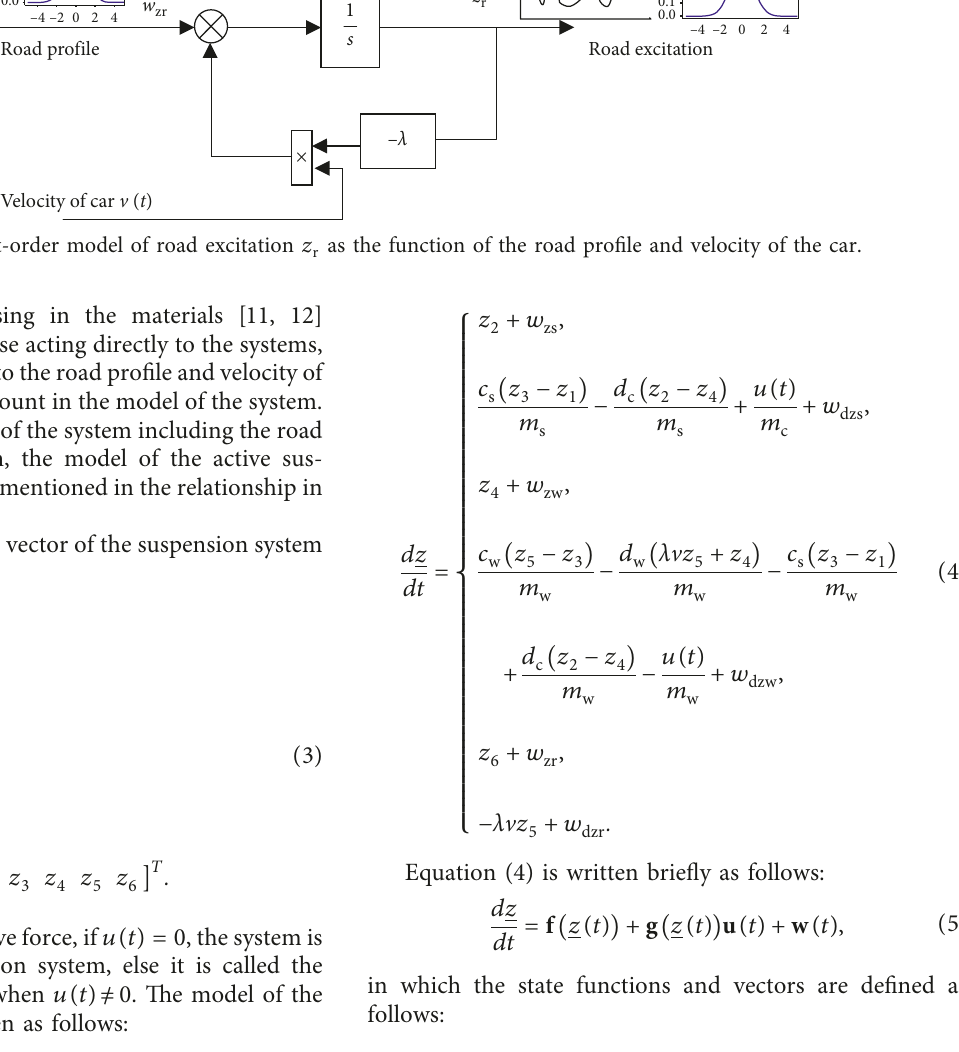
with the velocity of the car for the same road r